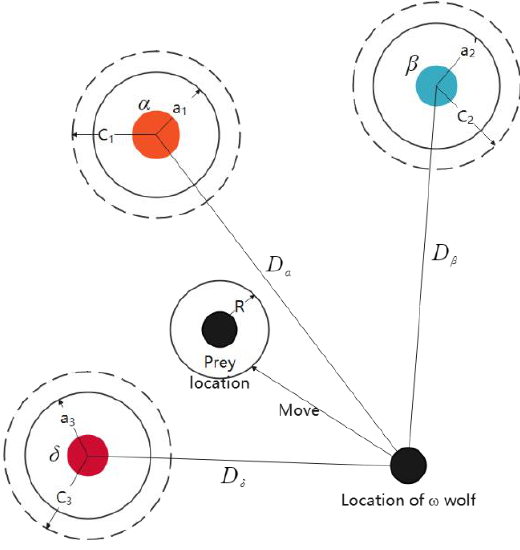
Figure 8. Schematic diagram of wolf location update. The mathematical expression for the change in the position of individual grey wolves throughout the update is as